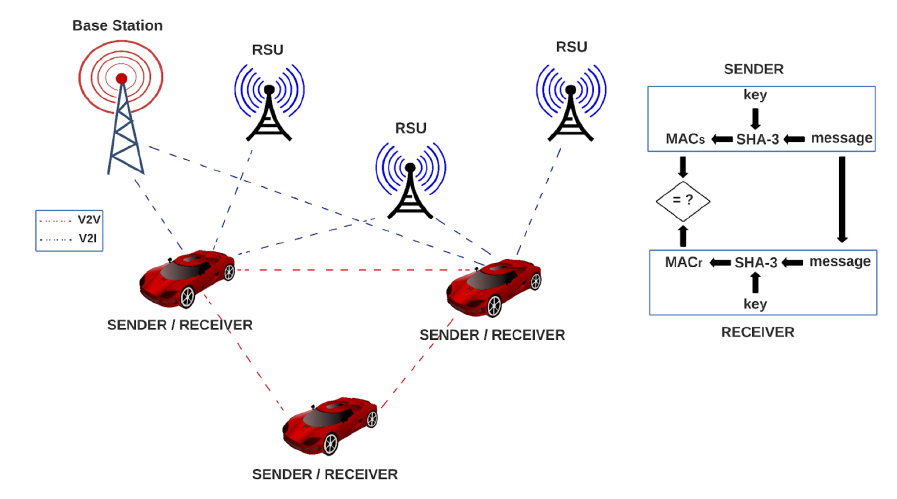
Figure 4. System model to implement SHA-3 architectures in VANETs.